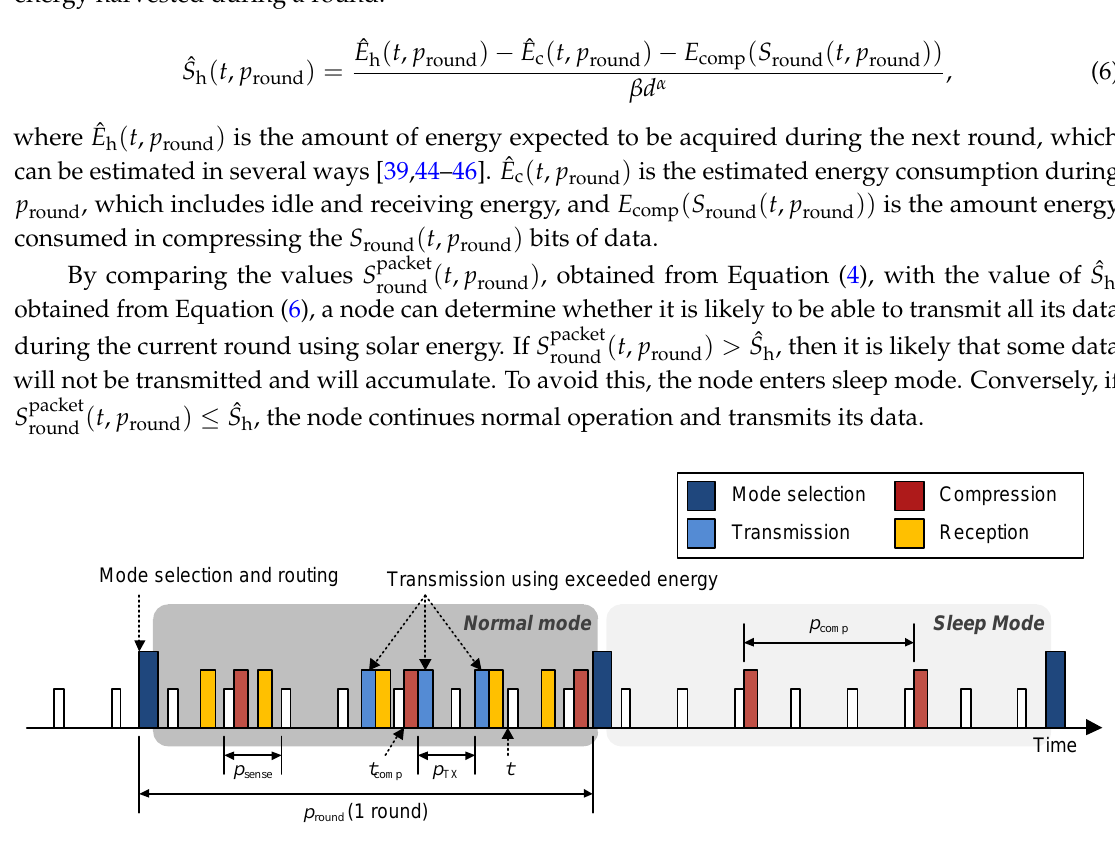
Figure 2. Process of the proposed